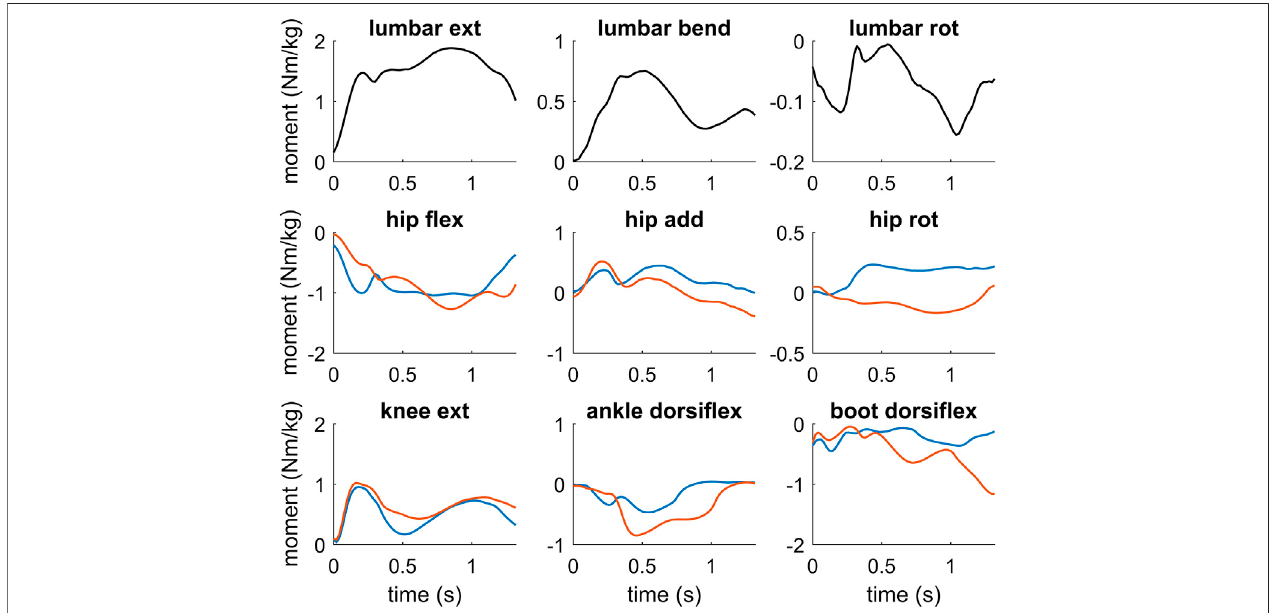
FIGURE5| Joint moments at thelumbar joint,hip,knee and ankle jointoftheinsideleg (blue) and theoutside leg (red) aswellasthe passivejointmoment induced bytheskibootattheanklejoint.Jointmomentsarerepresentedasinternaljointmomentsandhip fl exion(hip fl ex),adduction(hipadd)andinternalrotation(hiprot),knee extension (knee ext) and ankle dorsi fl exion (ankle dorsi fl ex) moments are denoted as positive. At the lumbar joint, lumbar extension (lumbar ext), lateral bending (lumbar bend) and left rotation (lumbar rot) moments are denoted as positive.